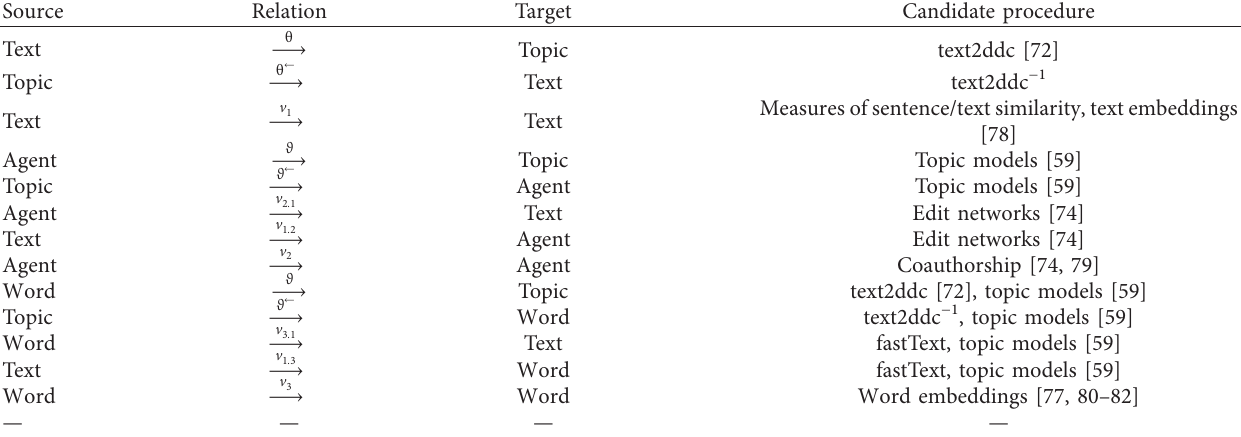
Table 2: Building blocks of topic networks (texts, topics, words, agents, etc.), their relations according to Figure 8, and candidate procedures for weighting the corresponding arcs (last